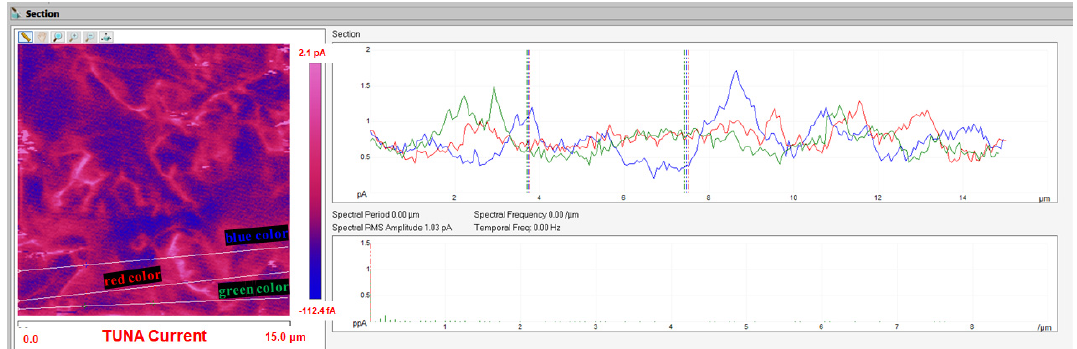
Figure 11. Shape of the current changes associated with the TUNA current image of the EM+5%G+0.5%CNF sample. Using FTIR spectroscopy, we carried out an analysis of the curing behavior of the multifunctional nanocomposite through the variation in the band intensity of the func- tional groups, first at room temperature (before the curing treatment) and then at the two highest temperatures of 125 °C and up to 200 °C, which correspond to the temperatures programmed for the curing cycle of the investigated samples. In Figure 12, where spec- troscopic analysis of the EM+5%G+0.5%CNF sample at room temperature and up to 125 °C for different times is reported, and in Figure 13, where the comparison between FTIR curves of the EM+5%G+0.5%CNF sample before curing (RT) and after curing (125 °C 1 h and 200 °C 3 h) is shown, the characteristic absorption peak of epoxide group at 908 cm − 1 is highlighted in order to observe its evolution during the polymerization reaction of the multifunctional nanocomposite. Figure 12. Spectroscopic analysis of the EM+5%G+0.5%CNF sample at room temperature and up to 125 °C for different times.